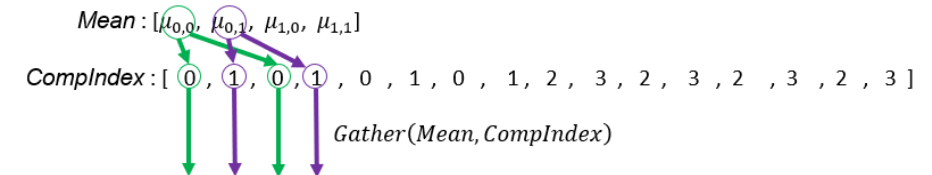
Figure 9. Illustration of the creation of duplicated mean vectors (Line 23 in Algorithm 4). In this example, the GMM of each set has two Gaussian components, and each mean vector will match with four samples because every set has four input samples. Therefore, the length of the duplicated mean vector array is 16 (the total number of mean vectors multiplied by the sample count in each set).